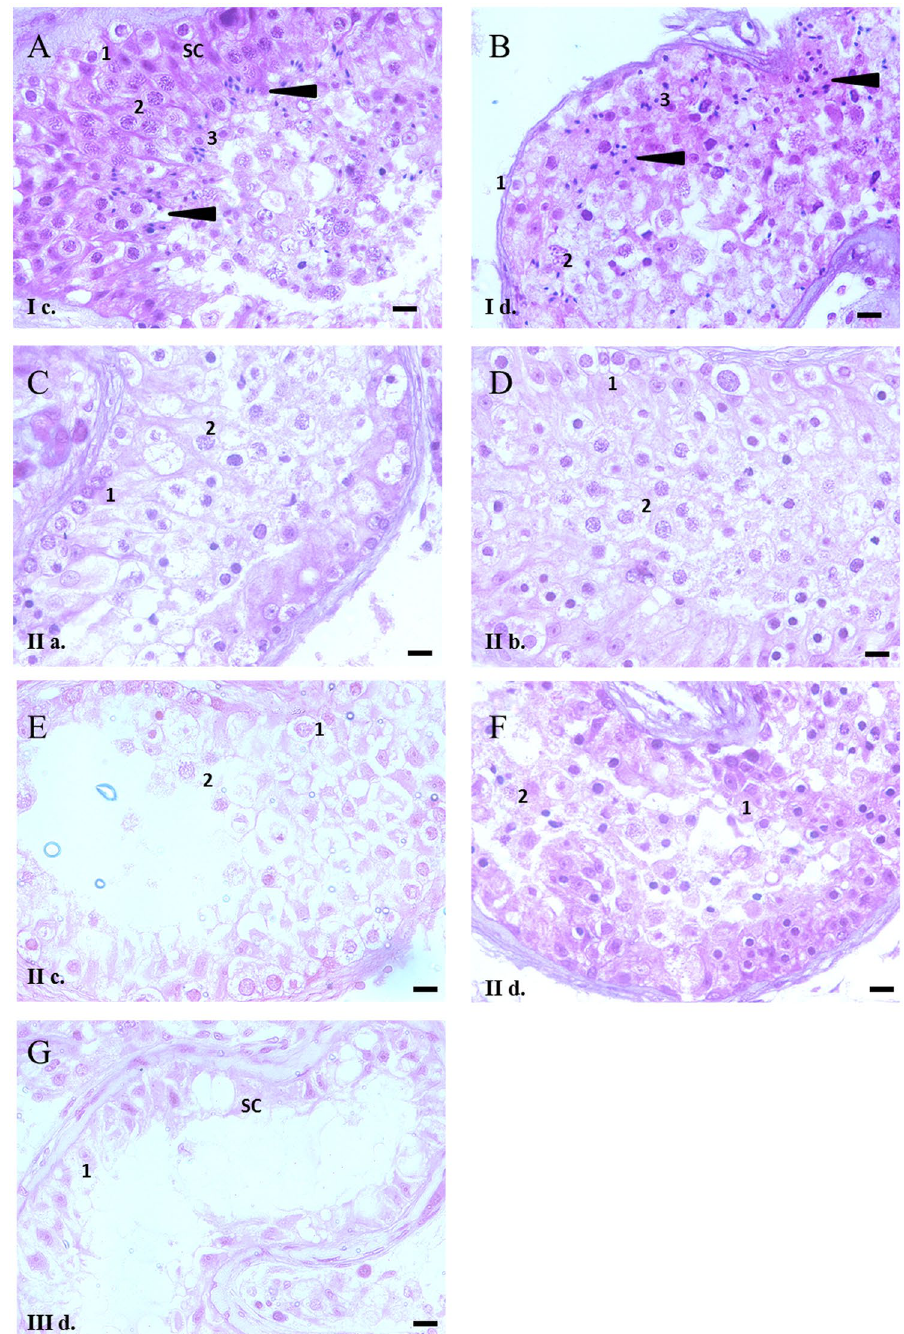
Figure 3. Histological Analysis of tissue samples representative for each group. 5 µ m thick testicular tissue sections were stained with Haematoxylin and Eosin and observed under light microscope. The cell types are annotated as SC (the Sertoli cells), 1 (spermatogonia), 2 (spermatocytes) and 3 (round spermatids). Elongated spermatids are marked with black arrowheads. Panels A-B: I c, I d: Group I (obstructive azoospermia, exhibiting haploid, diploid and double-diploid populations); Panels C-F: II a-d: Group II - (NOA with meiotic arrest, exhibiting diploid and double-diploid populations); Panel G: III d: Group III (NOA with pre-meiotic arrest, exhibiting diploid populations only) (Scale bar = 20 µ m, Magnification